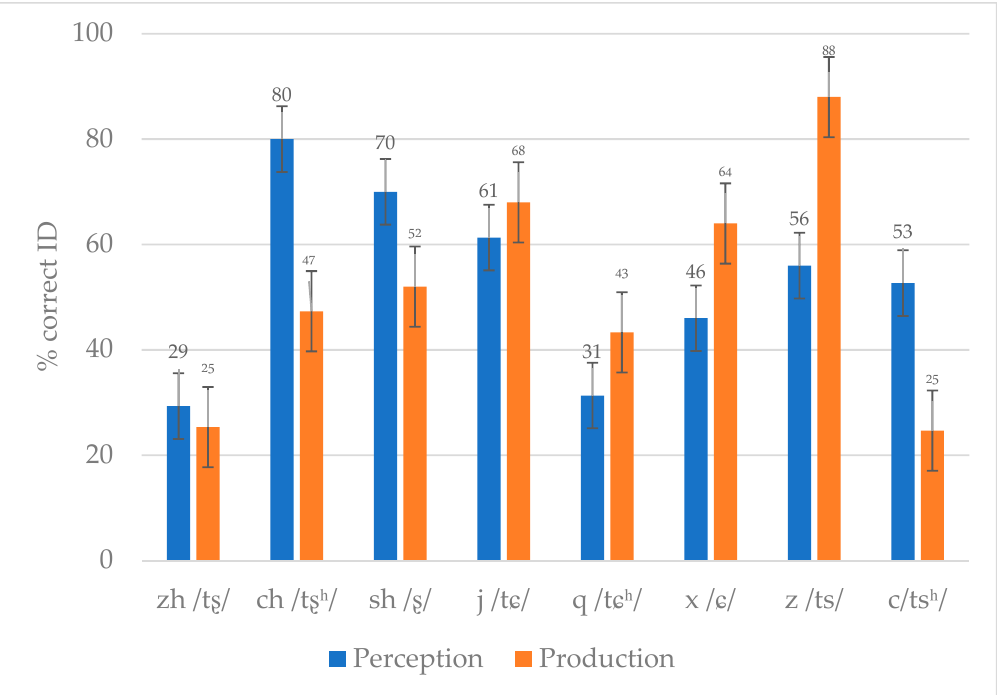
Figure 1. Mean % perception and production scores of Mandarin consonants by English CFL Learners (N = 25).